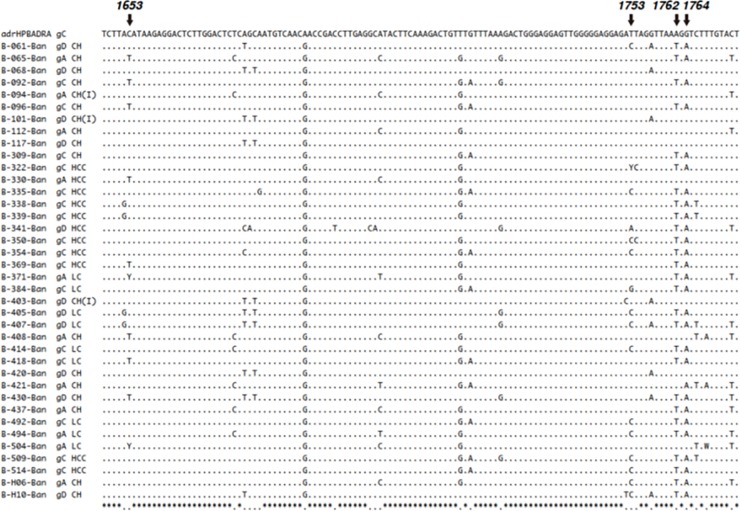
Mutations at 1762 and 1764 of Bangladeshi isolates.Full genome sequences were created in 38 HBV isolates from 38 patients with chronic HBV infection. At the top, the sequence of adrHPBADRA has been shown. B-061-Ban to B-H10-Ban (38 isolates) indicate the identification number of Bangladeshi isolates. The genotypes are shown as gA, gC, and gD on the right side of the identification number. The diagnosis of each isolate has been shown as: Chronic hepatitis (CH) with low HBV DNA (<2000 IU/ml) and normal ALT (Group-1); CH with high HBV DNA (>2000 IU/ml) and elevated ALT (>upper limit of normal) (Group-2); LC, cirrhosis of liver and HCC, hepatocellular carcinoma (Group-3). Also, G1895 mutation was found in 10 patients in our cohort (S1 Fig).